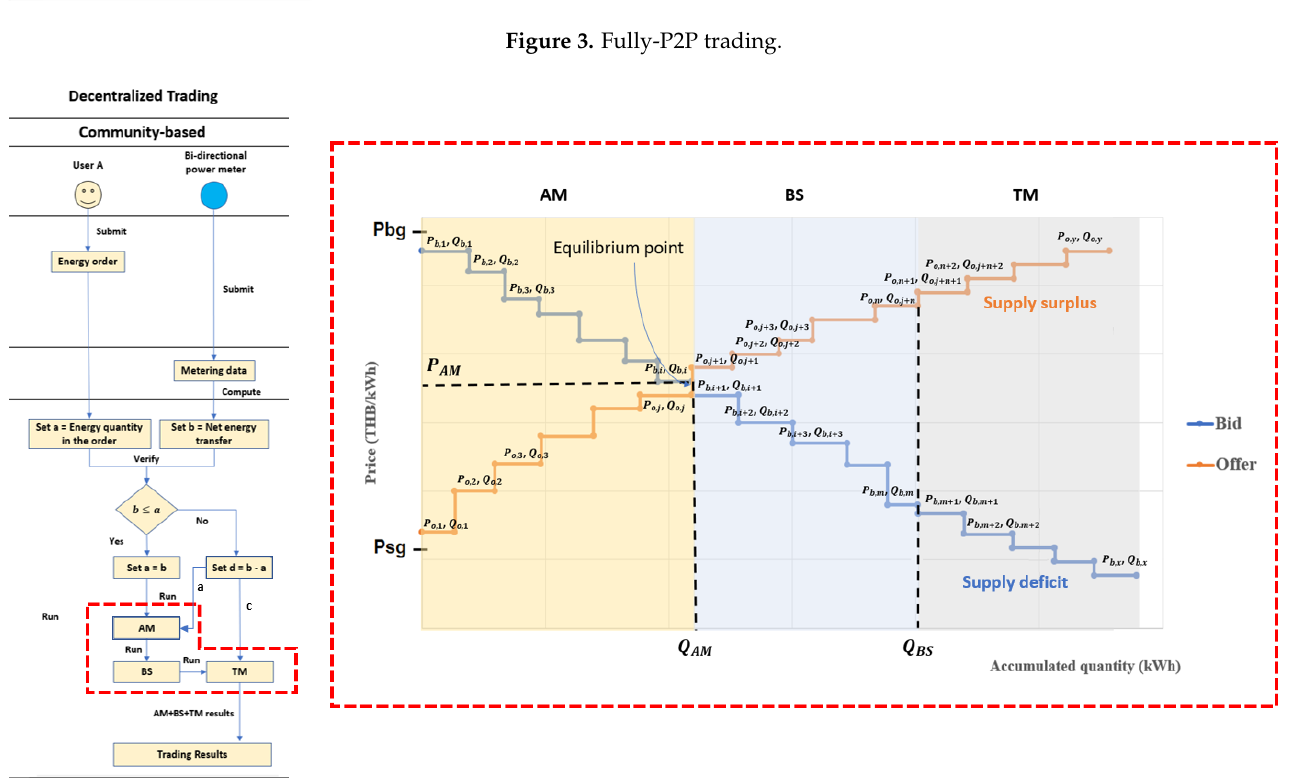
Figure 3. Fully-P2P trading.